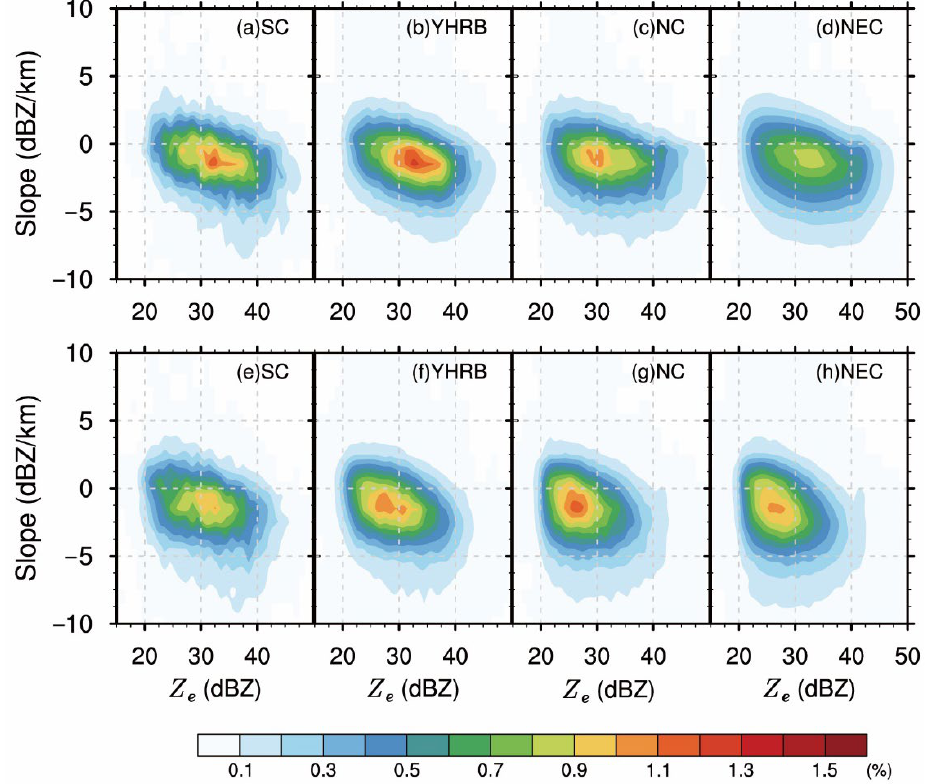
Figure 6. Frequency pattern in two-dimensional space of the slope of Z e from 3 km to 1 km above the SH and Z e at 2 km above the MSL over ( a , e ) SC, ( b , f ) YHRB, ( c , g ) NC and ( d , h ) NEC for the LPFs (upper panels) and NLPFs (lower panels) during summer in the time period 2014–2021.